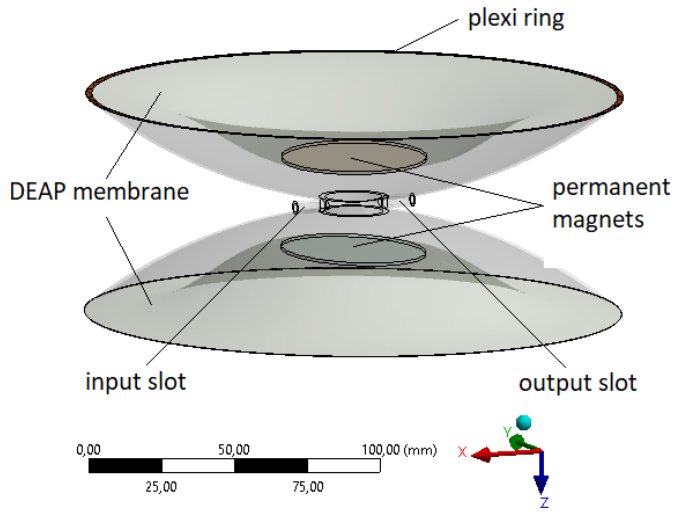
Figure 8. A pump concept built using a DEAP membrane and permanent magnets.